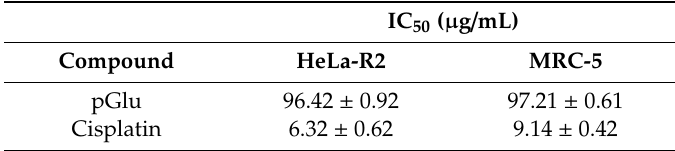
Table 3. Cytotoxic e ff ect of pyroglutamic acid and cisplatin on human cervical carcinoma cells and normal human